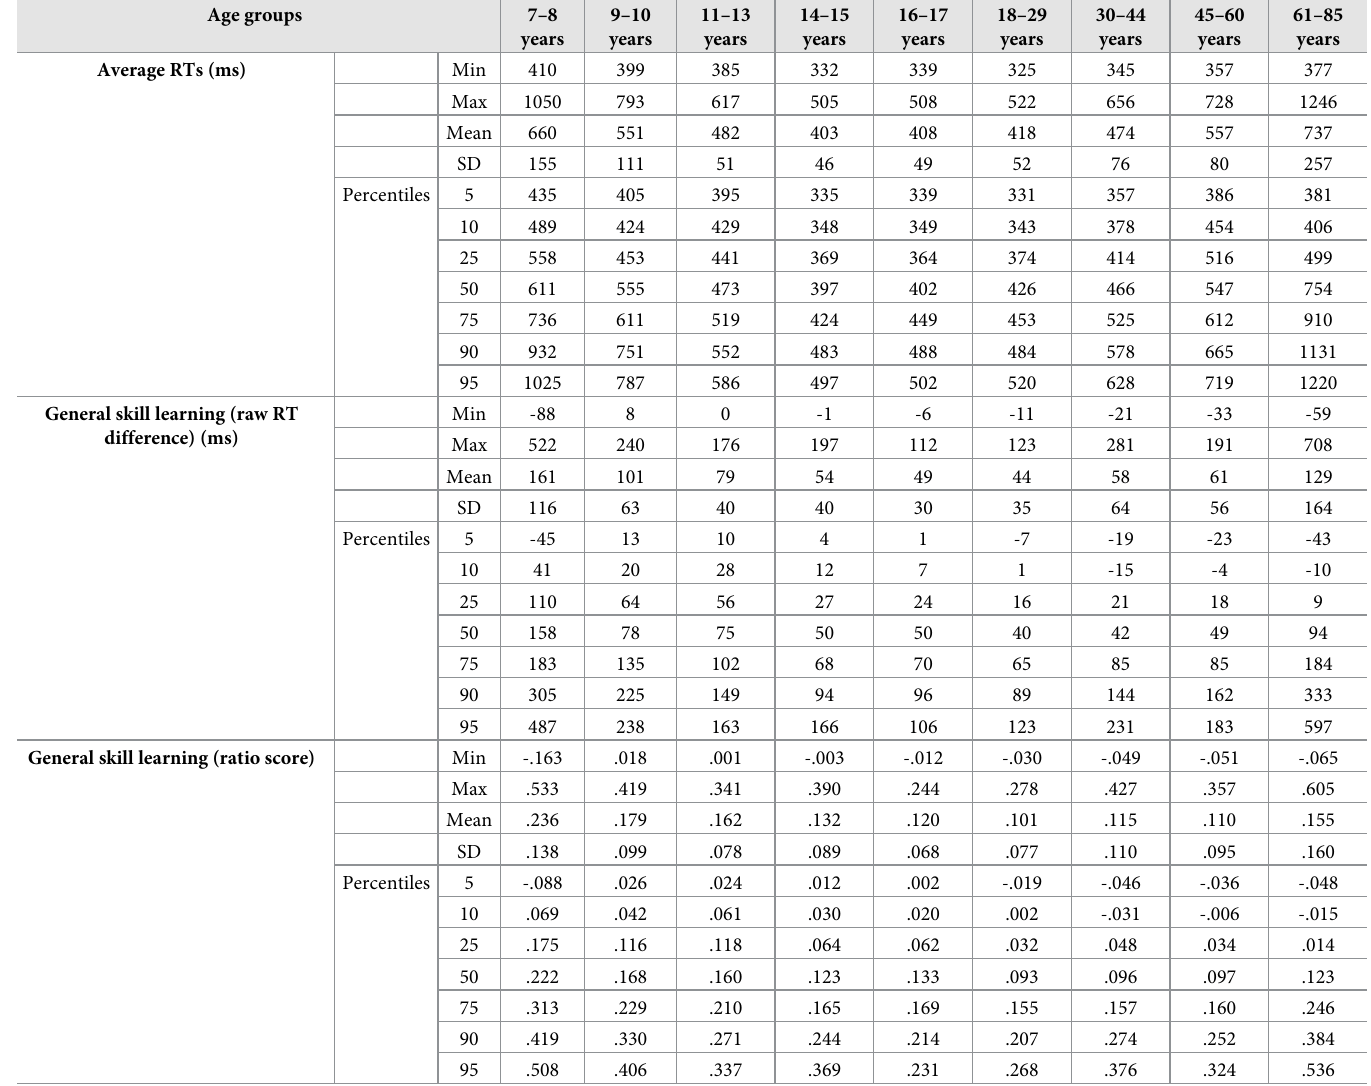
Table 3. Minimum and maximum values, mean, standard deviation (SD) and percentiles of average RTs and general skill learning for each age group. Age groups Average RTs (ms)